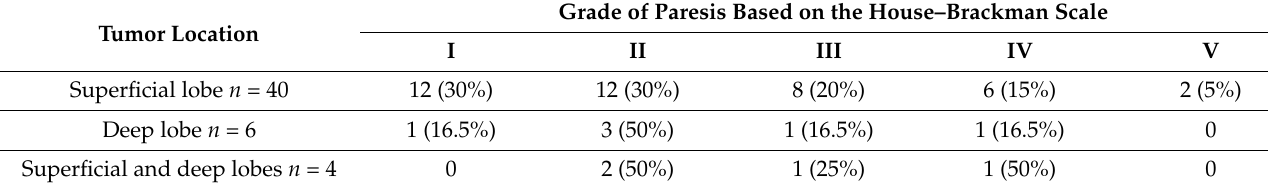
Table 1. Grade of paresis depending on tumor